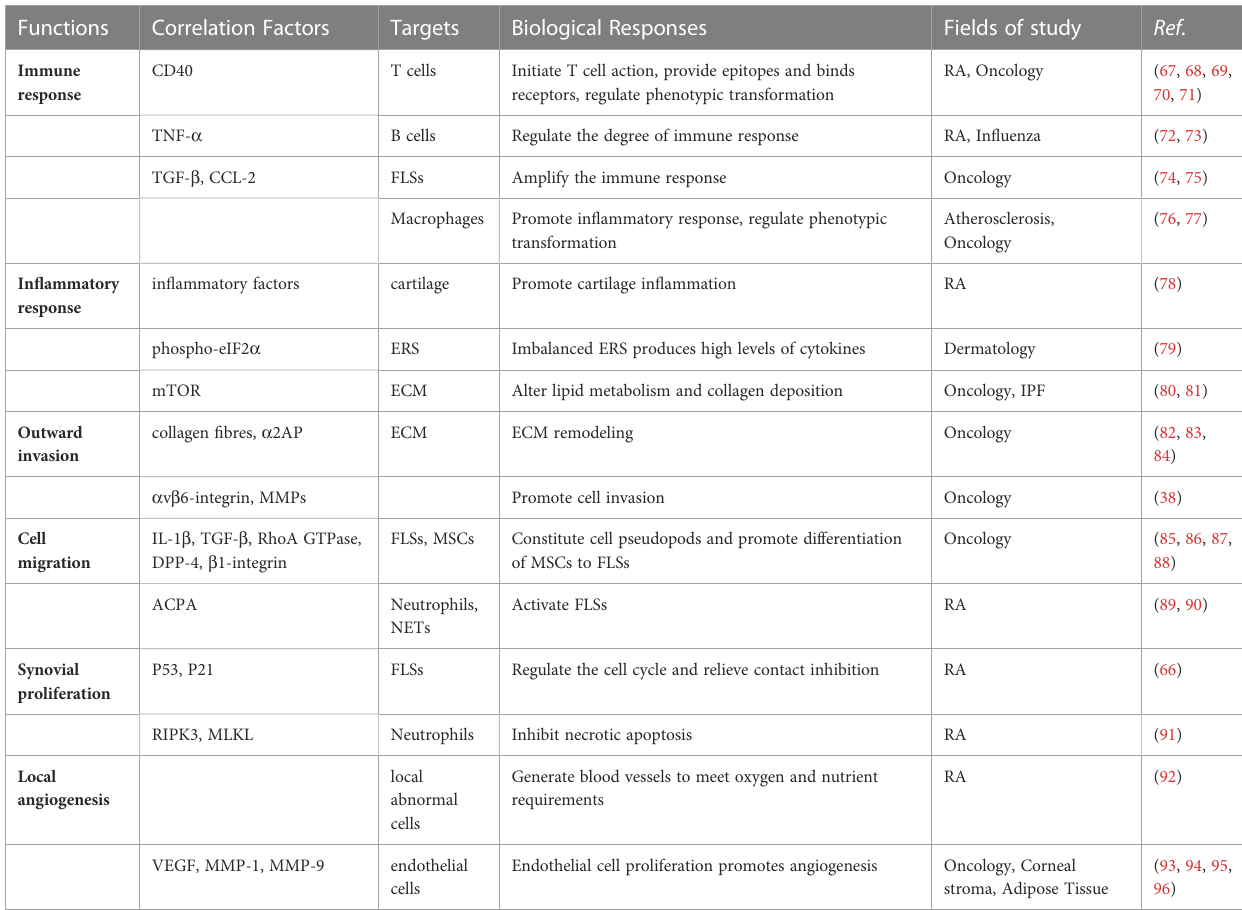
TABLE 1 Correlation factors, targets and biological responses associated with FAP-mediated FLSs functions.